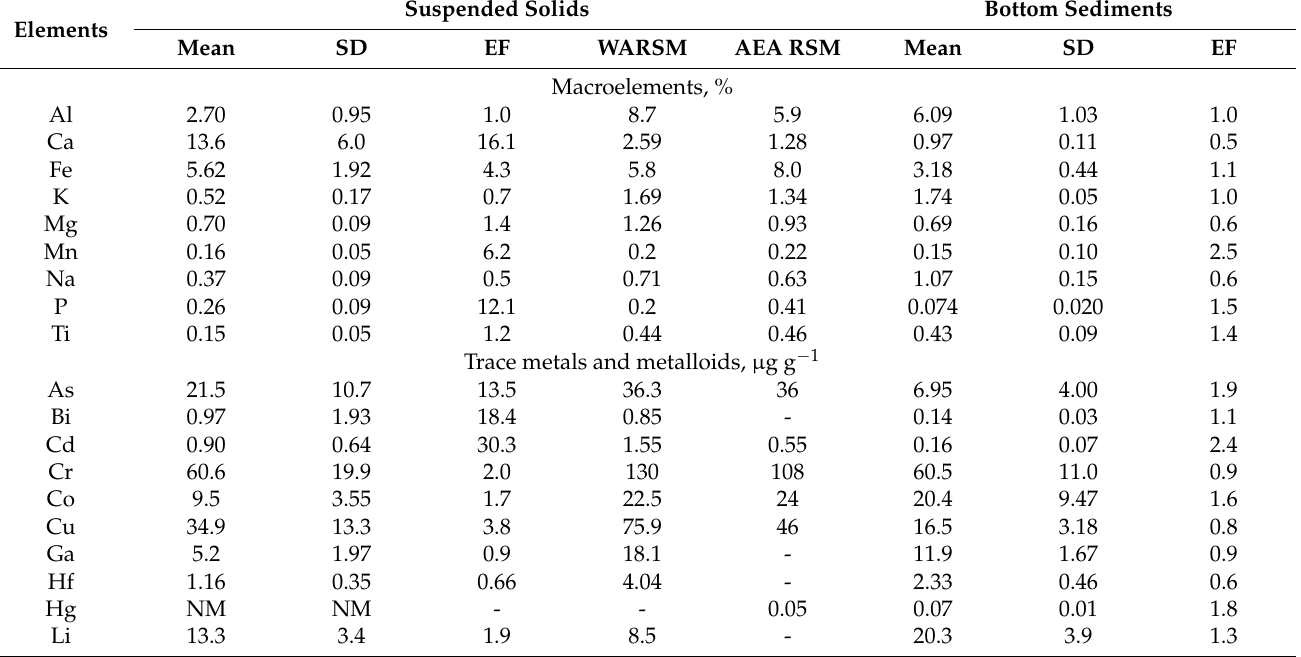
Table 4. Elemental composition of suspended solids and bottom sediments, Ob River ( n =